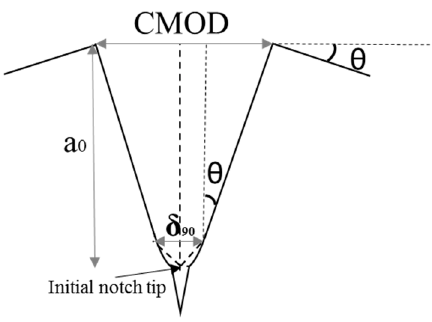
Figure 3. Schematic view of the notch geometry.